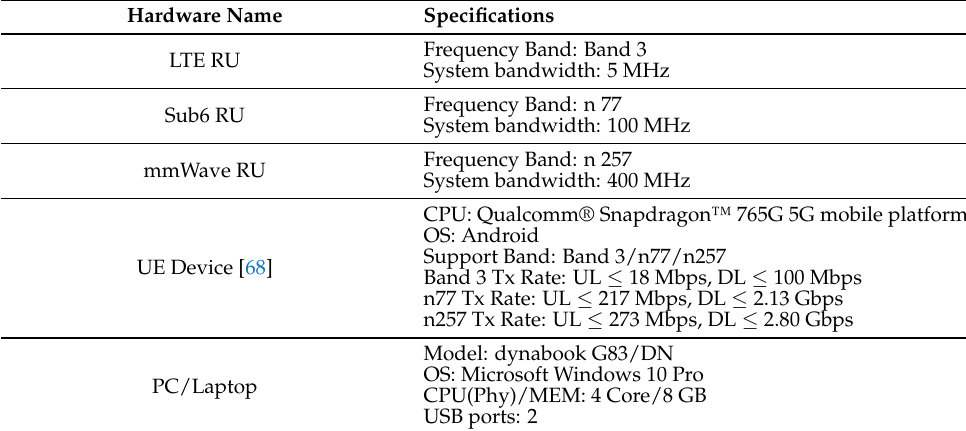
Figure 10. Outdoor PoC Field Design. Table 2. Hardware Equipment